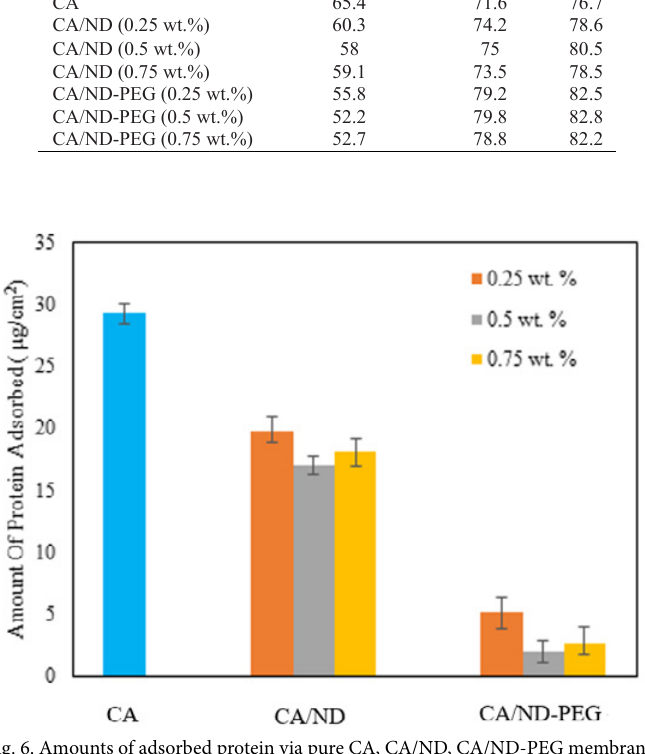
Fig. 6. Amounts of adsorbed protein via pure CA, CA/ND, CA/ND-PEG